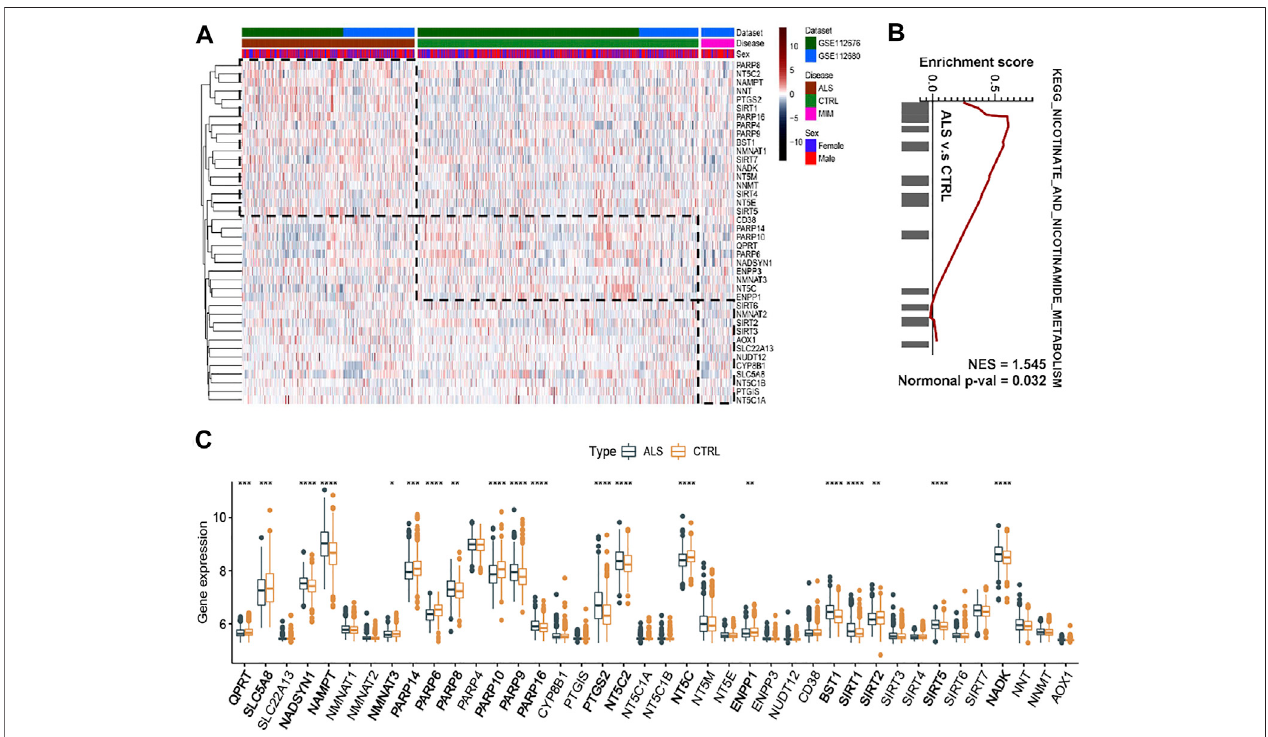
FIGURE 2 | NAD+ metabolism-related molecular patterns and GSEA in whole blood of ALS patients (A) Heatmap of NAD+ metabolism-related genes in ALS patients,controlsandALSmimics (B) DifferentialexpressionofNADmetabolism-relatedgenesinwholebloodofALSandcontrols (C) GSEAshowedthatthenicotinate and nicotinamide metabolism pathway are differentially enriched in ALS patients. ALS, Amyotrophic Lateral Sclerosis; CTRL, control; MIM, mimic; NES, normalized enrichment score; Normal p-val, normalized p value. * p < 0.05, ** p < 0.01, *** p < 0.001, and **** p < 0.0001.